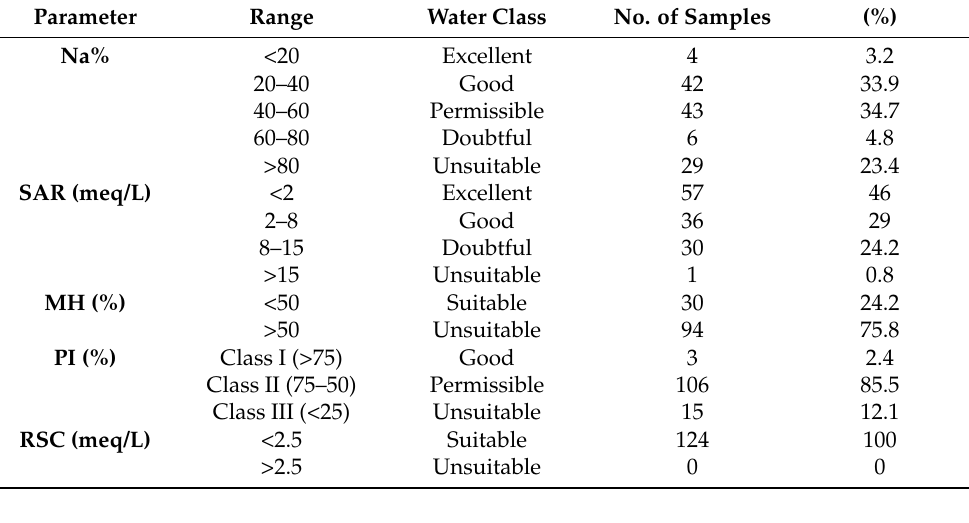
Table 5. Classification of groundwater samples for suitability for irrigation.